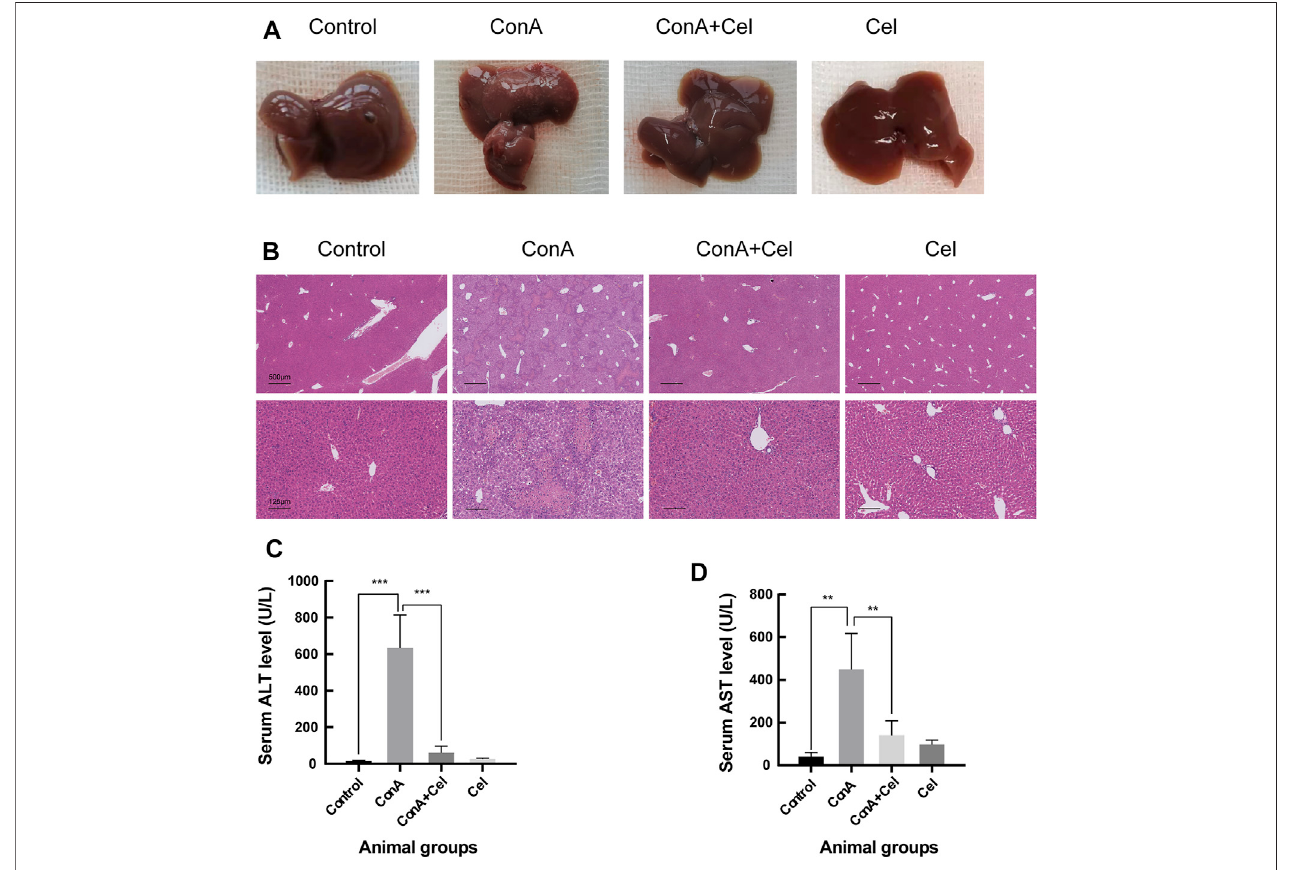
FIGURE 7 | ConA-induced liver damage was ameliorated in celastrol treated mice. (A) Gross appearance of livers. (B) Representative photomicrographs of HE stained liver sections. (C) Quanti fi cation of serum ALT ( **p < 0 . 01 , ***p < 0 . 001 ). (D) Quanti fi cation of serum AST.